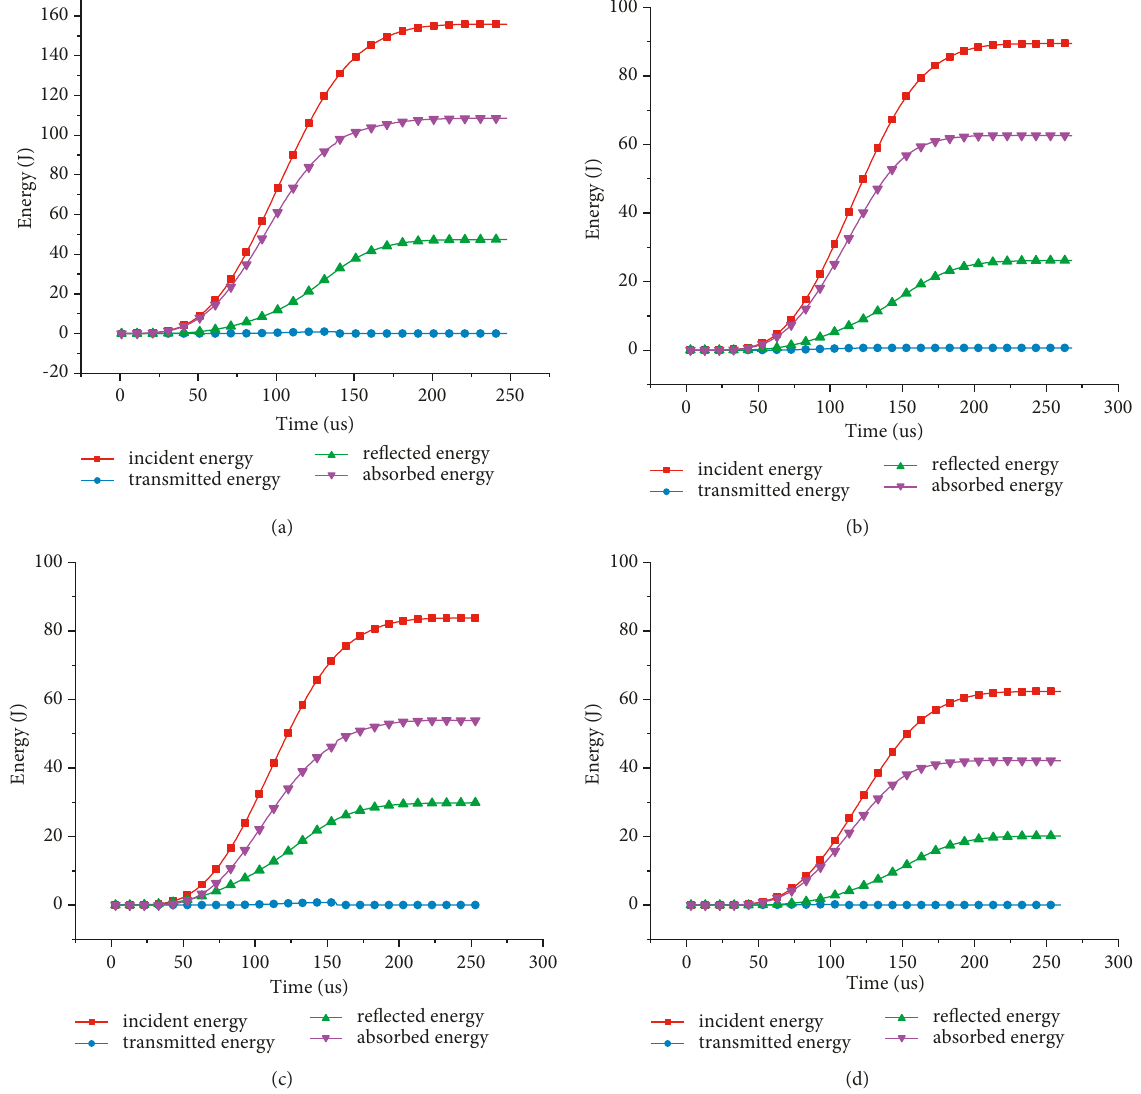
Figure 11: Energy time-history curve of the dynamic point load test at the conical angle of 60 ° . (a) Impact velocity 11.86m/s. (b) Impact velocity 8.97m/s. (c) Impact velocity 8.63m/s. (d) Impact velocity